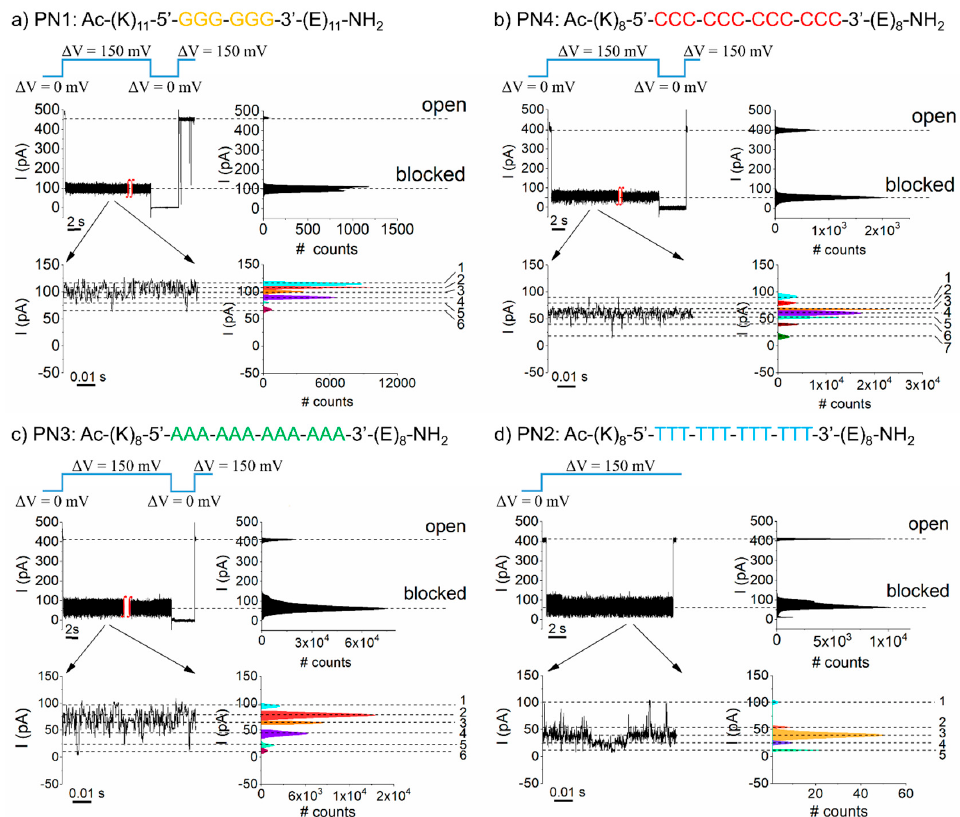
Figure 2. Discrimination of individual bases on homopolymeric PNAs. Selected traces illustrating the reversible blockades of the ion current through an open α -HL pore due to interactions with the (PN1) G 6 ( a ), (PN4) C 12 ( b ), (PN3) A 12 ( c ), and (PN2) (T 12 ) ( d ) PNAs. The all-points histogram on the right-hand side of each original trace illustrates the values of the average blockade level needed to calculate the total relative blockade of the nanopore (see, also, Table 2). All such experiments were carried out with PNAs added to the trans side of the membrane [9 µ M], in an electrolyte containing 3 M potassium chloride (KCl) and 10 mM HEPES, pH = 7.4, and at a transmembrane potential of ∆ V = +150 mV. In certain instances, the nanopore remained stuck in the “blocked” state upon capturing the PNA constructs; thus, a flip of the ∆ V to 0 mV was required to dislodge the fragments from the nanopore. Close inspection of the residual currents through the PNA-blocked nanopores revealed supplementary blockade substates (zoomed-in excerpts on each panel), also quantified from the corresponding all-points histograms (see, also, Table 2).